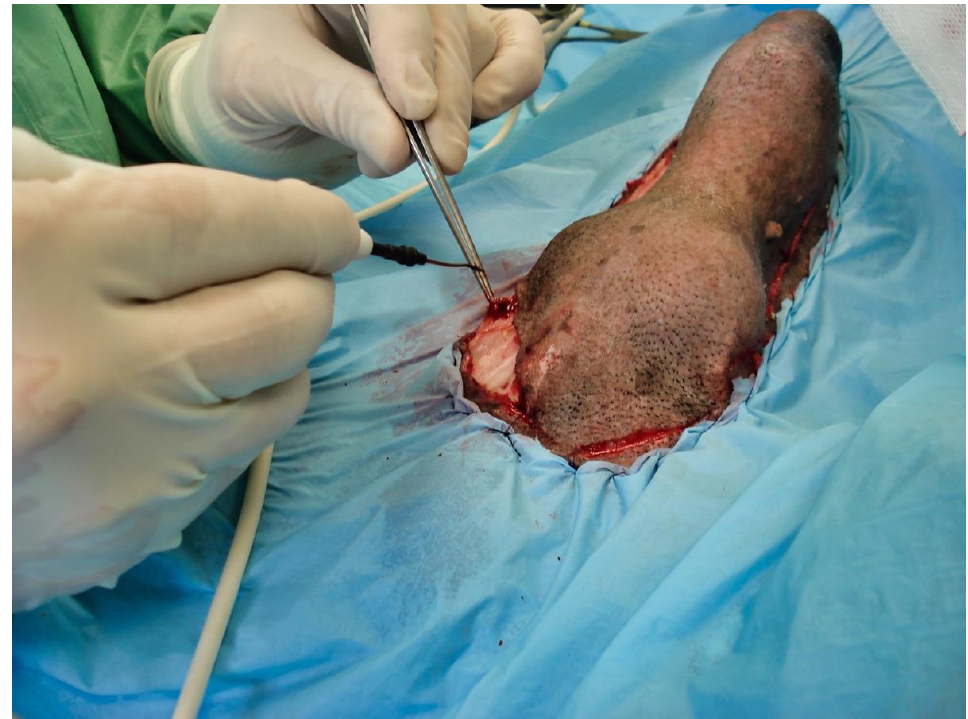
Vet. Sci. 2022 , 9 , x FOR PEER REVIEW Figure 4. Intraoperative view of penile amputation, showing the limits of the incision.